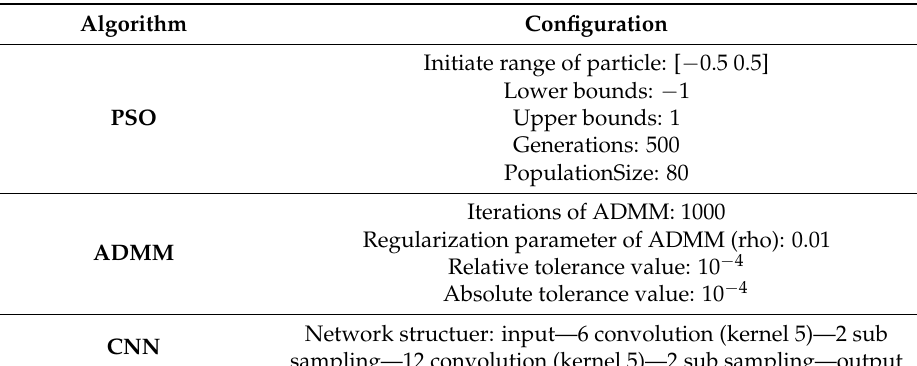
Table 3. Software and hardware configuration.